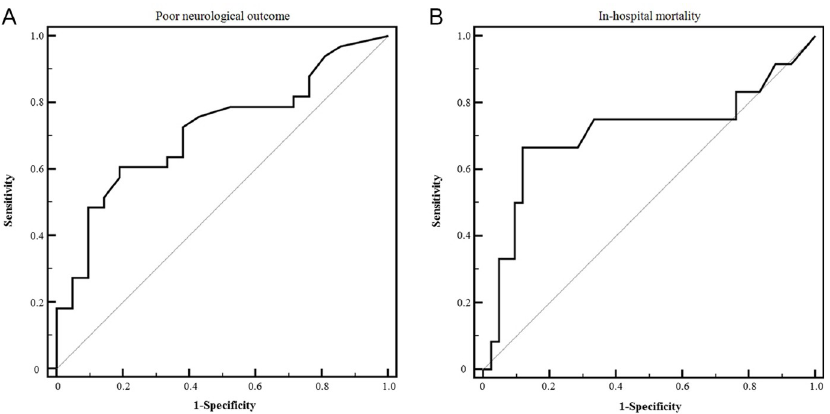
Fig 3. Receiver operating characteristic (ROC) curves for the prediction of clinical outcomes. ROC curves for the prediction of (A) poor neurological outcome and (B) hospital mortality associated with maximal intracranial pressure within 6 h after barbiturate coma therapy (n =